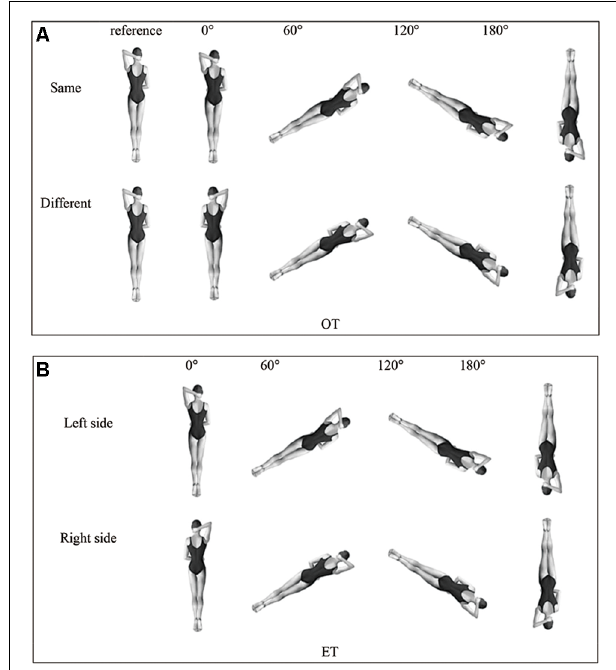
FIGURE 1 | Task stimuli in OT condition (A) and ET condition (B) . Copyright by QA International, 2017. All rights reserved. Abbreviations: OT, object-based transformations; ET, egocentric